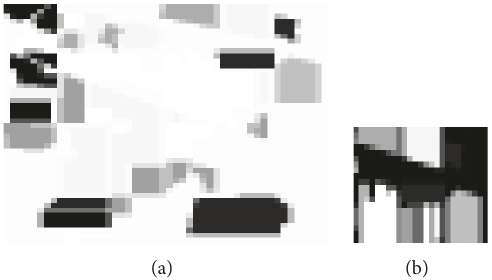
Figure 4: Simulated hyperspectral imagery (the thirtieth band): (a) image 1 ( 48 × 48 ); (b) image 2 ( 20 × 25 ).